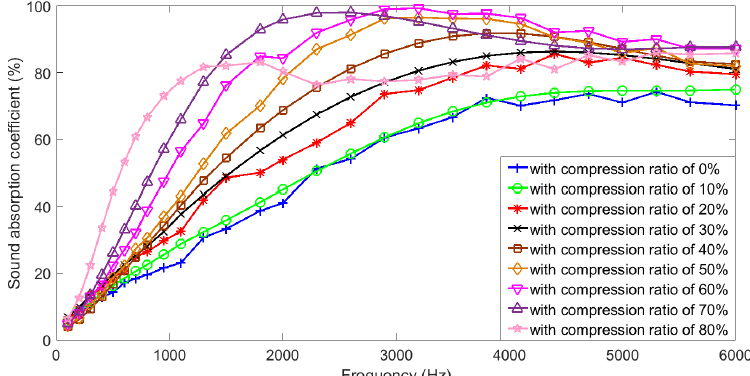
Figure 7. Comparisons of sound absorption coefficients of the samples with different compression ratios when thickness of the detected sample was 20 mm.